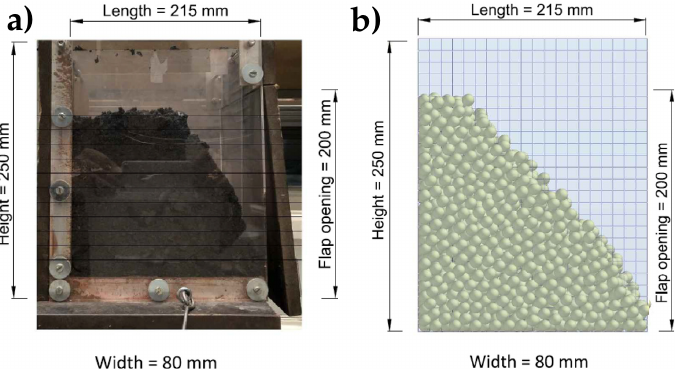
Figure 14. The ledge test for measuring the static angle of repose by [116] ( a ) the experiment and ( b ) the DEM model. Reproduced with permission from Advanced Powder Technology; published by Society of Powder Technology Japan,